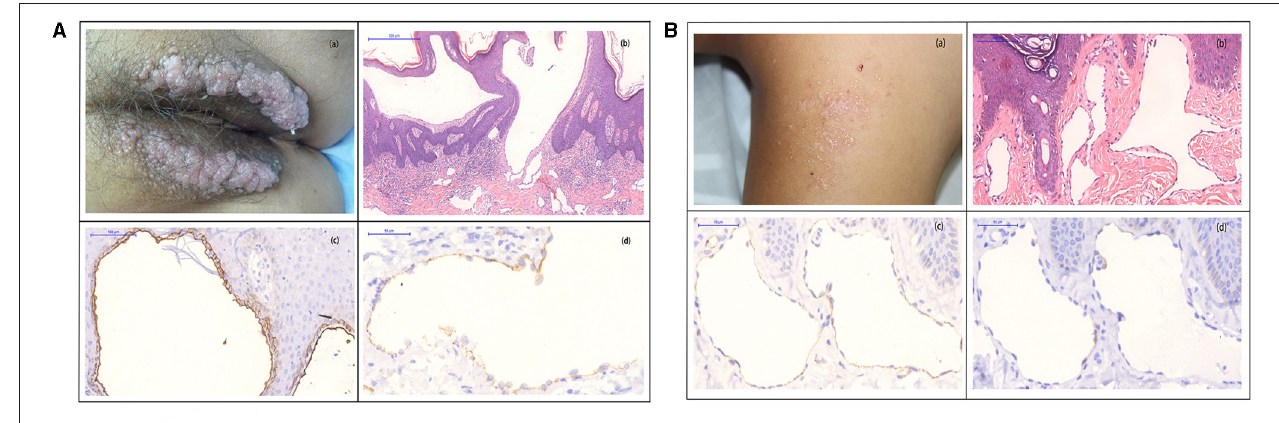
FIGURE 2 | (A) (a) Biopsy specimens were taken from transparent blister-like beads on a string from the vulva. (b) H&E staining showed cystic-dilated spaces, containing numerous erythrocytes and leukocytes in the papillary and upper reticular dermis (original magnification, 100 × ). (c) D2-40 staining showed two layers of the inner (red arrow) and outer (black arrow)-flattened endothelial (original magnification, 200 × ). (d) Immunohistochemistry showed CD31 expression in the inner-flattened endothelium (original magnification, 400 × ) (300 dpi × 300 dpi). (B) (a) Biopsy specimens were taken from the complexion papule in the dorsum, and the papule has a little lymph. (b) H&E staining showed evidently extended lymphatic vessels in the papillary and upper dermis (original magnification, 200 × ). (c) High magnification of D2-40 staining showed a single endothelial layer (red arrow), the absence of two endothelial layers of the inner- and outer-flattened endothelium (original magnification, 400 × ). (d) Immunohistochemical staining for CD31 showed negative expression in the flattened endothelium (original magnification, 400 × ) (300 dpi × 300 dpi).